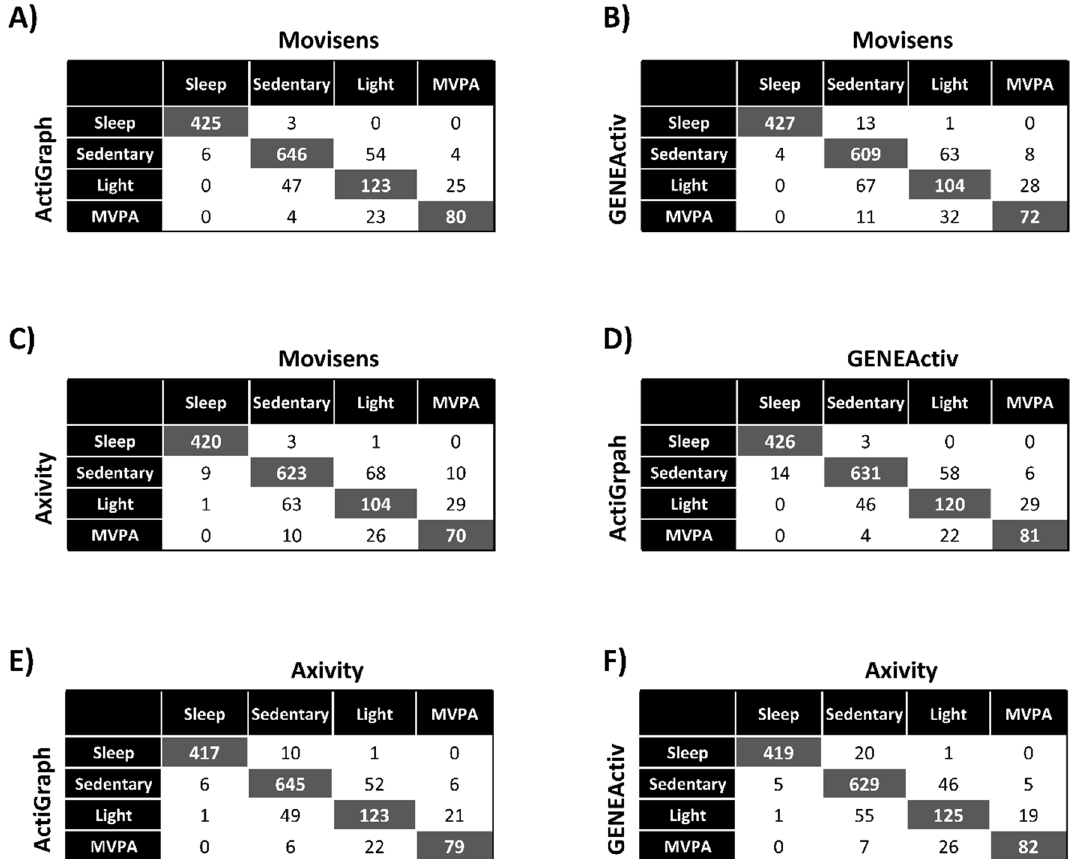
Figure 1. Pairwise confusion matrices for the sleep, sedentary time, light PA and MVPA expressed in min/day as determined by the different monitors. MVPA moderate-to-vigorous physical activity, PA physical